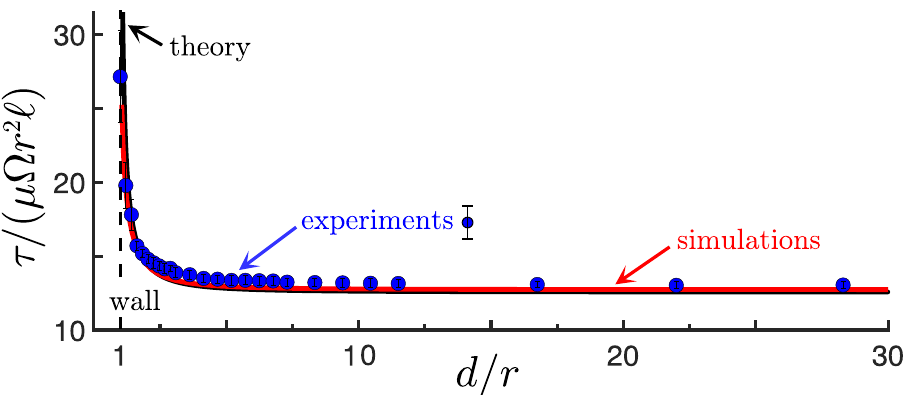
Figure 7. Dimensionless torque, τ / ( µ Ω r 2 (cid:96) ) , for a cylinder versus scaled boundary distance ( d / r ), where µ is the dynamic viscosity, and (cid:96) is the length of the cylinder. The boundary distance is scaled by the cylindrical radius r as measured to the centerline of the cylinder: theory by Jeffrey and Onishi [27] (solid black line), optimized MIRS simulations (solid red curve), and dynamically similar experiments (solid blue circles). The numerical simulations were optimized by adjusting the discretization factor γ c to minimize the MSE between theory and simulation (the minimum MSE is 0.36%). The MSE between experiments and theory was large near the boundary because the theory goes to infinity at d / r = 1. Outside of the near-boundary region ( d / r ≥ 2), the MSE is less than 1%.